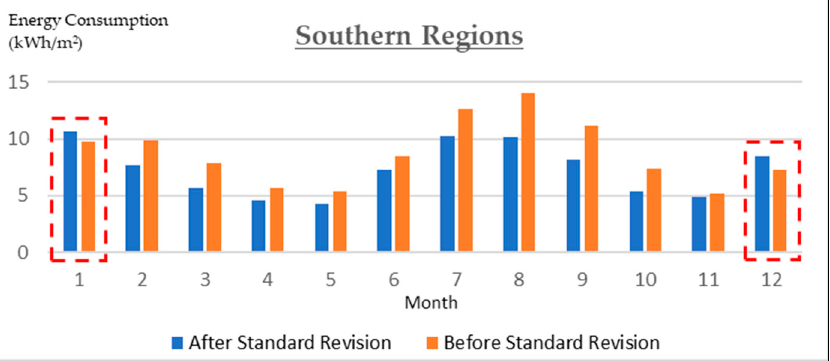
Figure 4. Bar chart of the monthly energy consumption of courthouse buildings in the southern region based on the revision of the building insulation thickness standard.